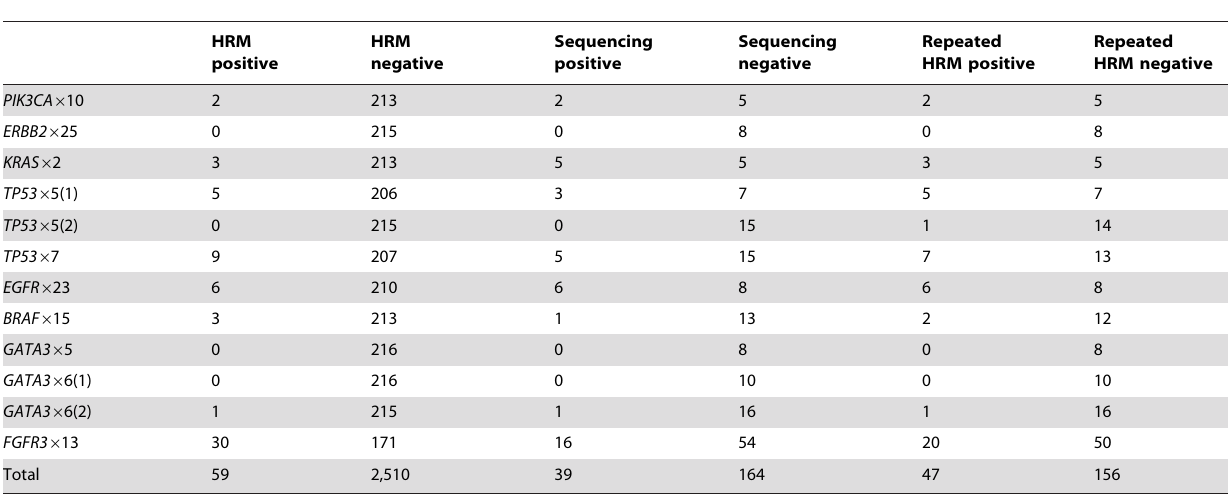
Table 2. Results of mutation screening by HRM (initial screen and repeat) and sequencing from frozen samples.